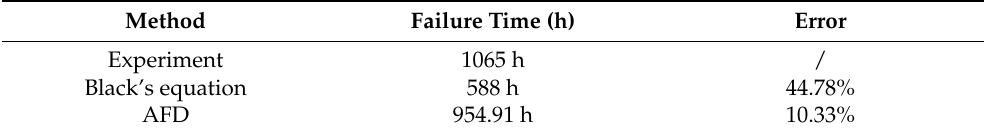
Table 4. Failure time results based on different methods.